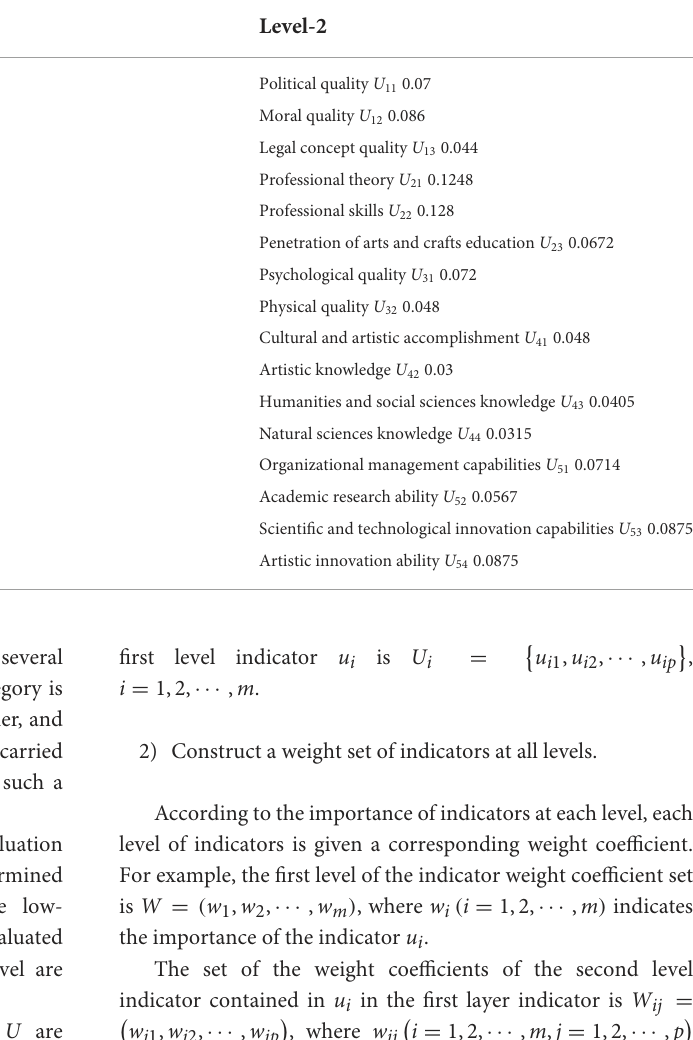
TABLE 2 Weightage table of the indicator